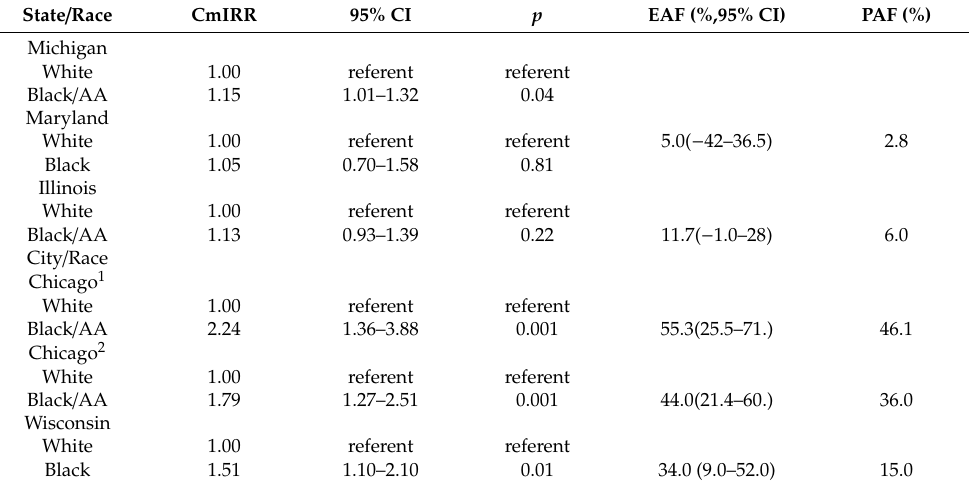
Table 3. Black–White Risk Di ff erentials in Mortality in Selected States, MD, MI, IL, the 9th through